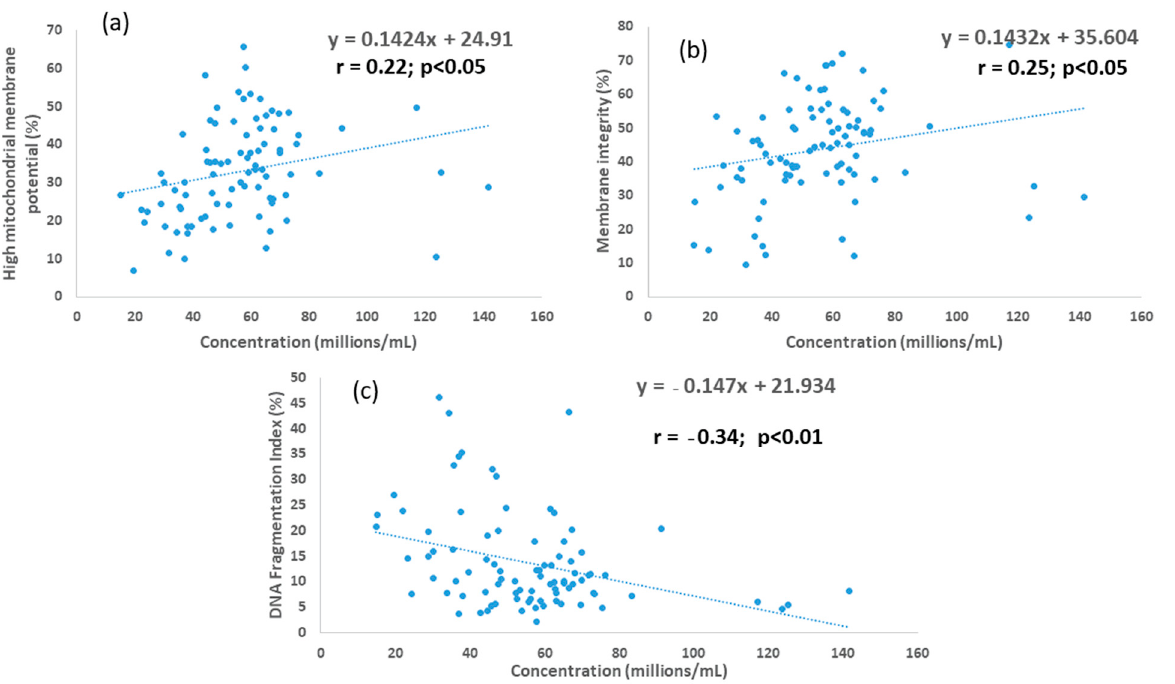
Figure 2. Associations between sperm concentration and ( a ) membrane integrity; ( b ) mitochondrial membrane potential; and ( c ) DNA fragmentation index for young bull ejaculates processed by single-layer centrifugation.